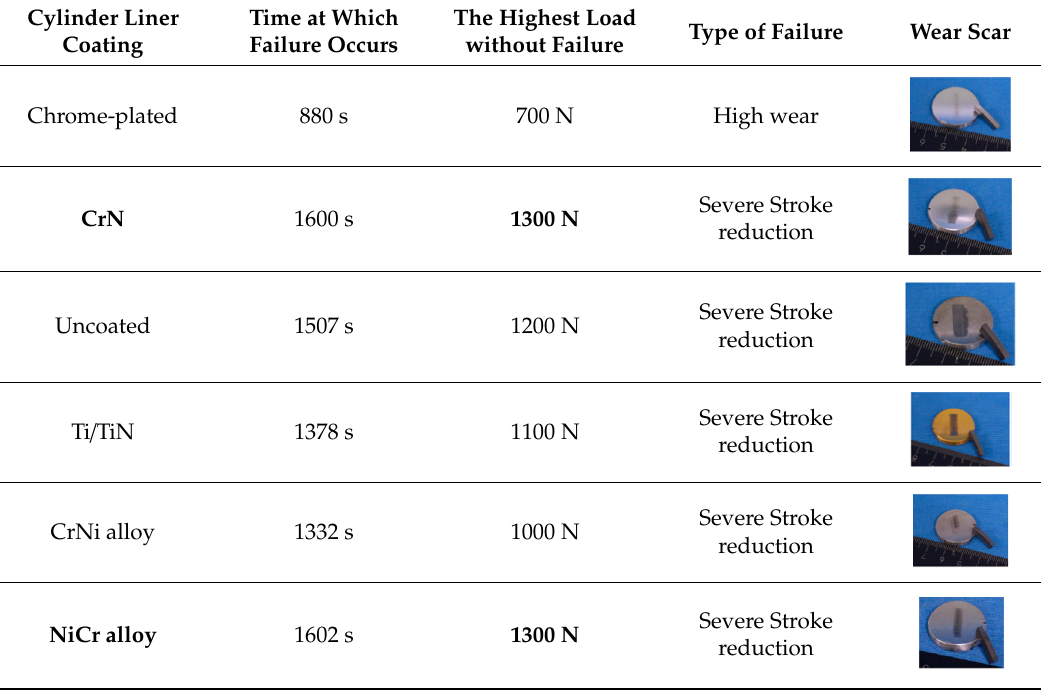
Table 4. Engine test surface condition for ST52 cylinder liners, cast-iron piston rings and oil consumption